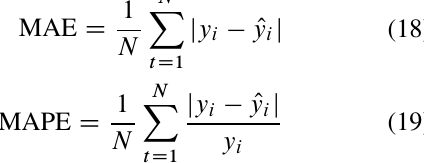
Fig. 5 Two-stage training strategy